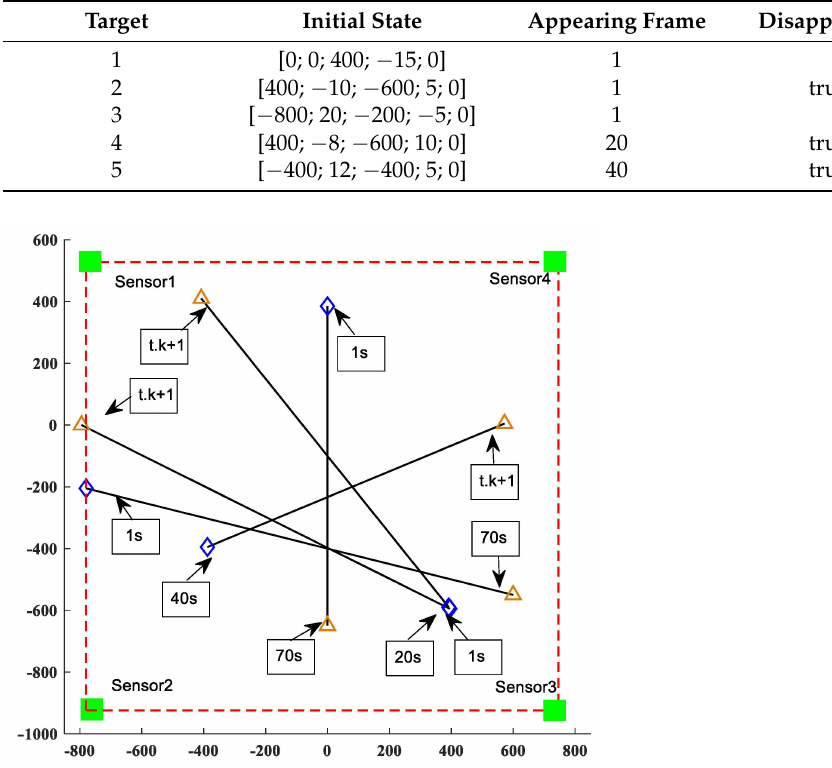
Figure 6. Linear CV model’s moving target trajectory.